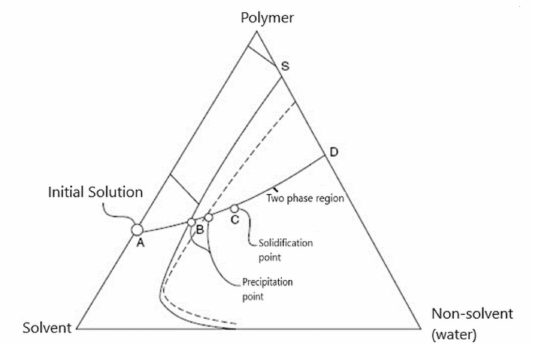
Figure 3. Diagram of the polymer–solvent–nonsolvent ternary